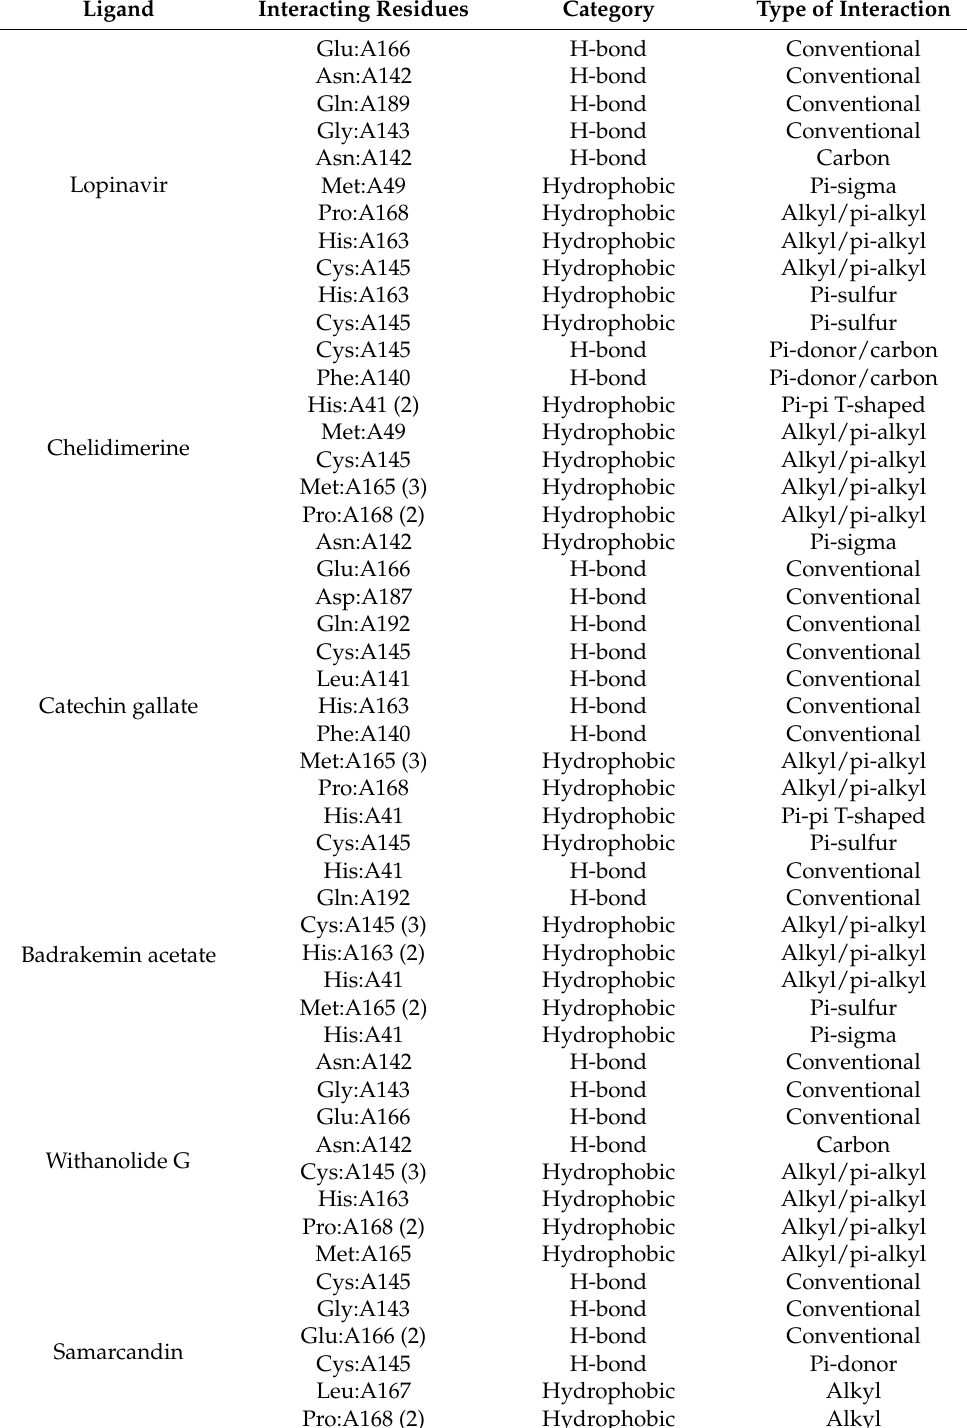
Table 2. Molecular interactions between the best ligands and the receptor main protease